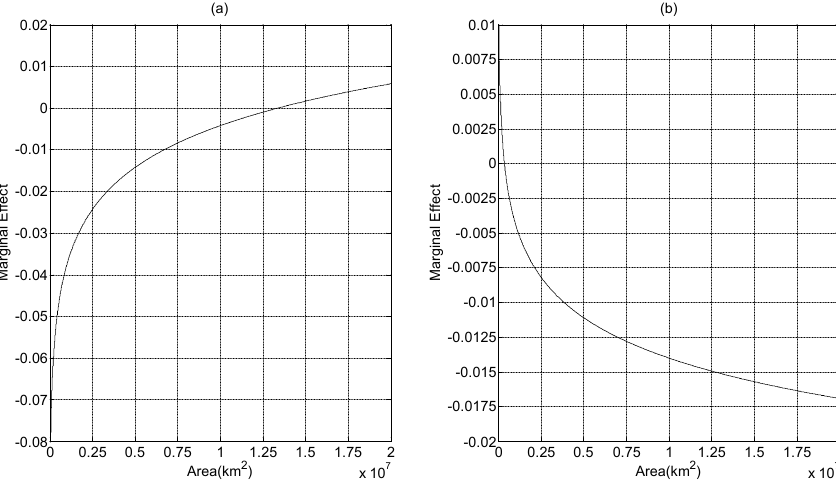
∗ / ∗∗ / ∗∗∗ indicates significance at 0.1/0.05/0.01 levels (two-tailed test). Standard errors shown in parentheses.